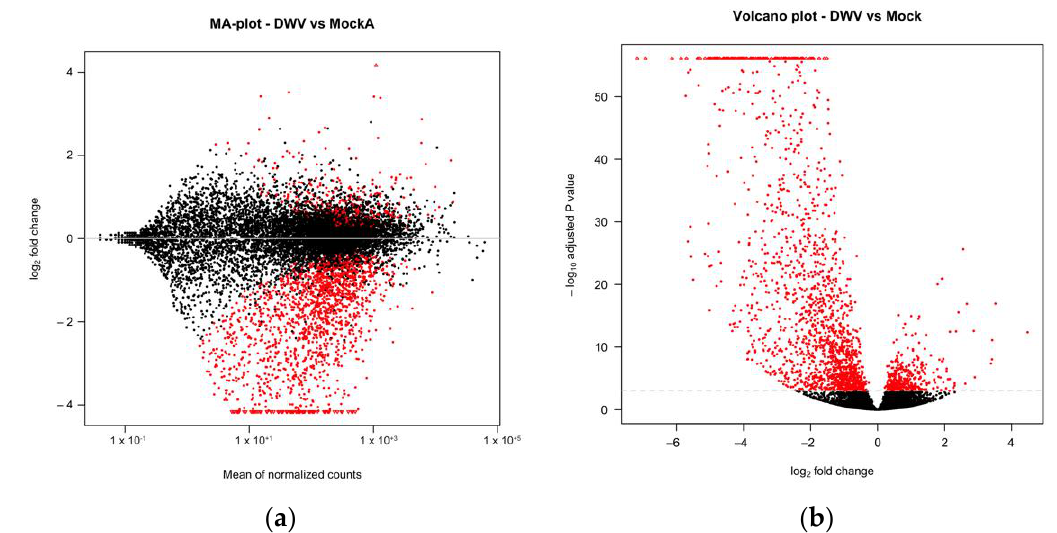
Figure 2. Expression of A. mellifera genes was compared by DESeq2 with MA ( a ) or volcano ( b ) plots. The mean expression level (log2 counts per million (CPM)), the fold change (log2 FC), and the FDR-adjusted p values are shown for each gene. Red points indicate differential expression (FDR ≤ 0.001 determined by DESeq2).